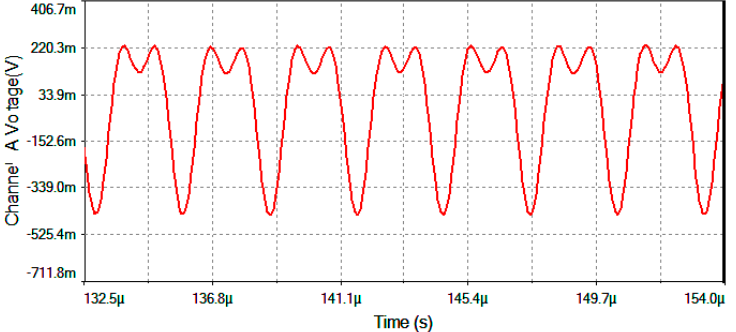
Figure 15. V detection voltage signal (after the transimpedance amplifier) for Ω = +30 °/s.